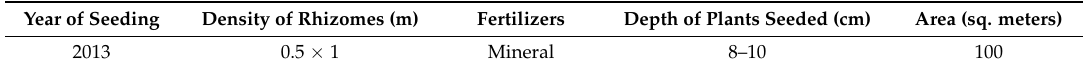
Table 5. Overview table for Miscanthus × Giganteus .